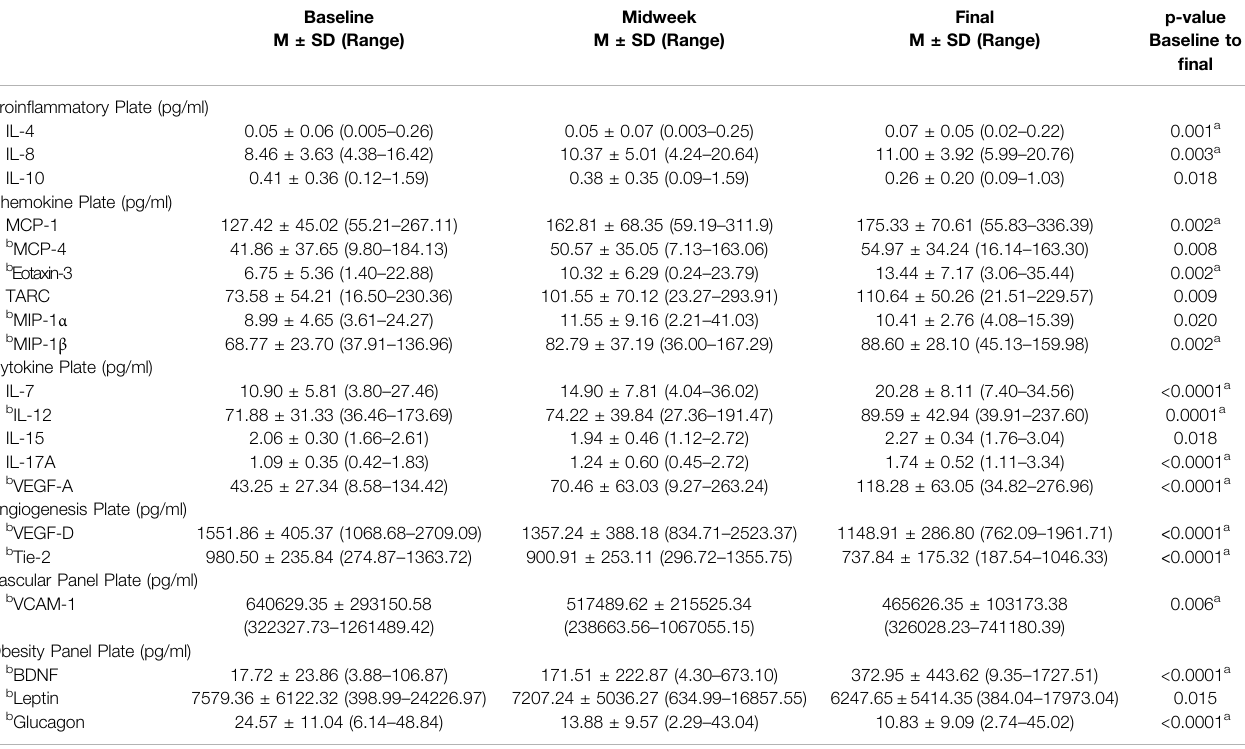
TABLE 6 | Serum analyte levels. Twenty analytes changed signi fi cantly between baseline and endpoint; 13 remained different following Bonferroni-Holm correction.